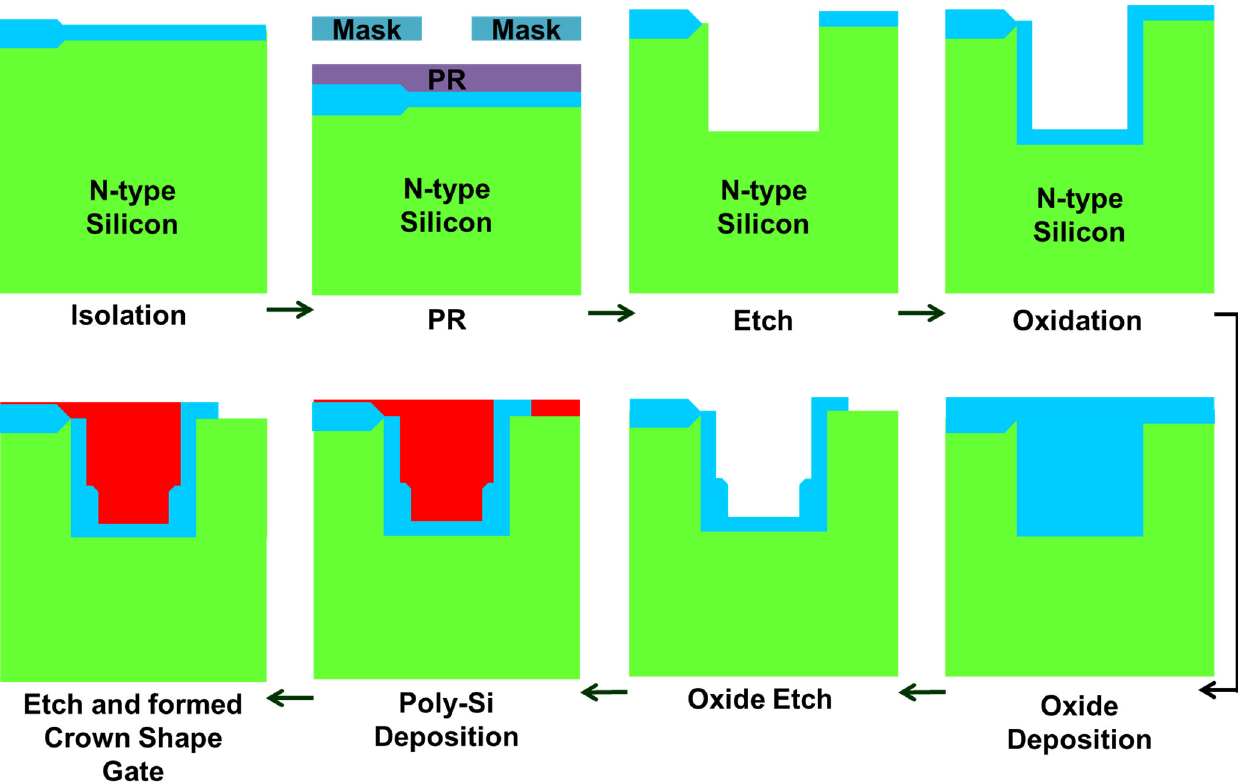
Figure 2. A fabrication process of the S-IGBT. The crown-shaped gate can be fabricated without additional photo-lithography.